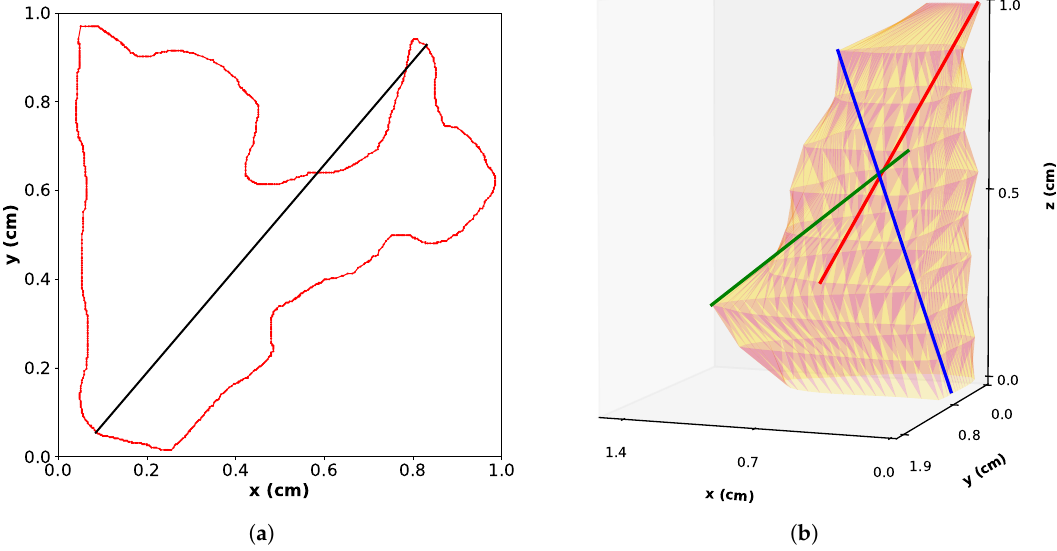
Figure 4. Principle of Feret calculation. ( a ) 2D Feret for the contour of Figure 3b. The 2D Feret diameter is drawn as the black line. ( b ) 3D principal, secondary and tertiary Feret for the grain of Figure 3c. The 3D principal, secondary and tertiary Feret are drawn as the red, green and blue lines,